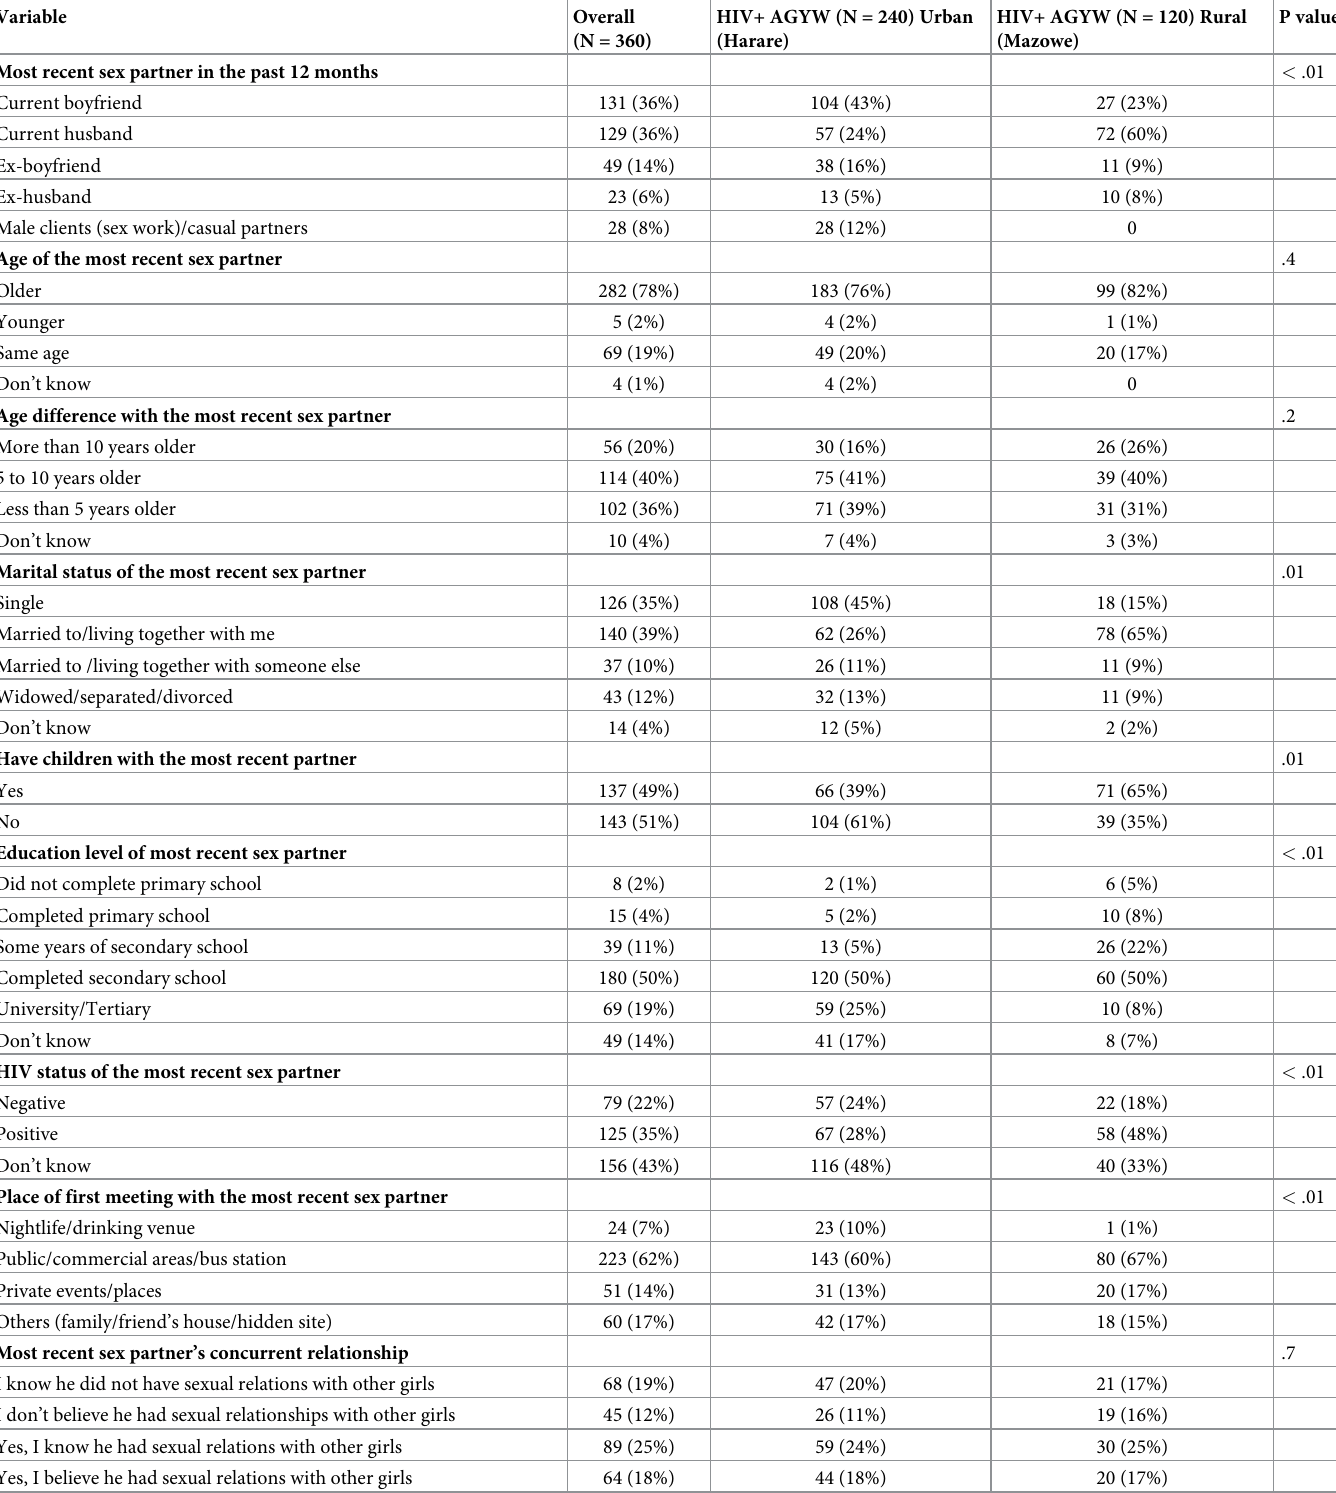
HIV+ AGYW (N = 240) Urban HIV+ AGYW (N = 120) Rural P value (N = 360) (Harare) (Mazowe)